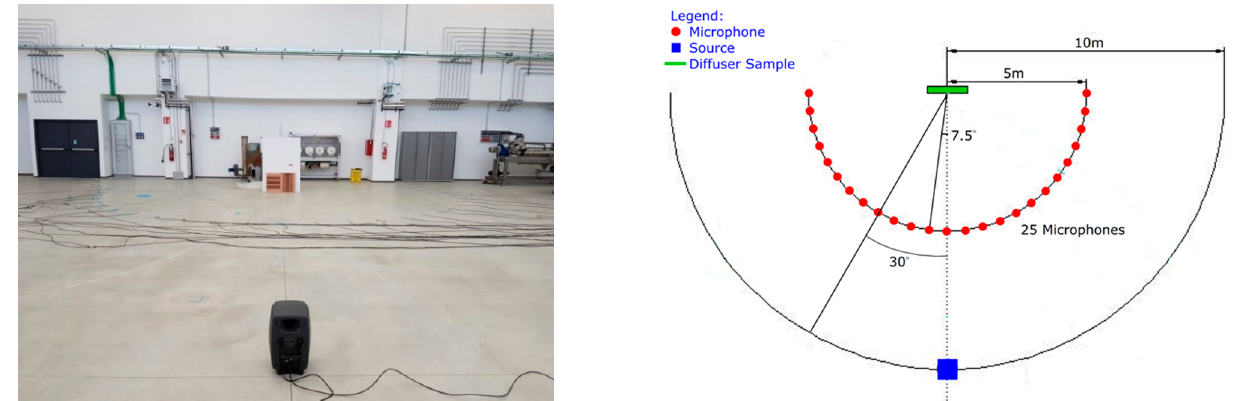
Figure 3. Equipment disposition inside the reverberant laboratory of the University of Parma (Room B).